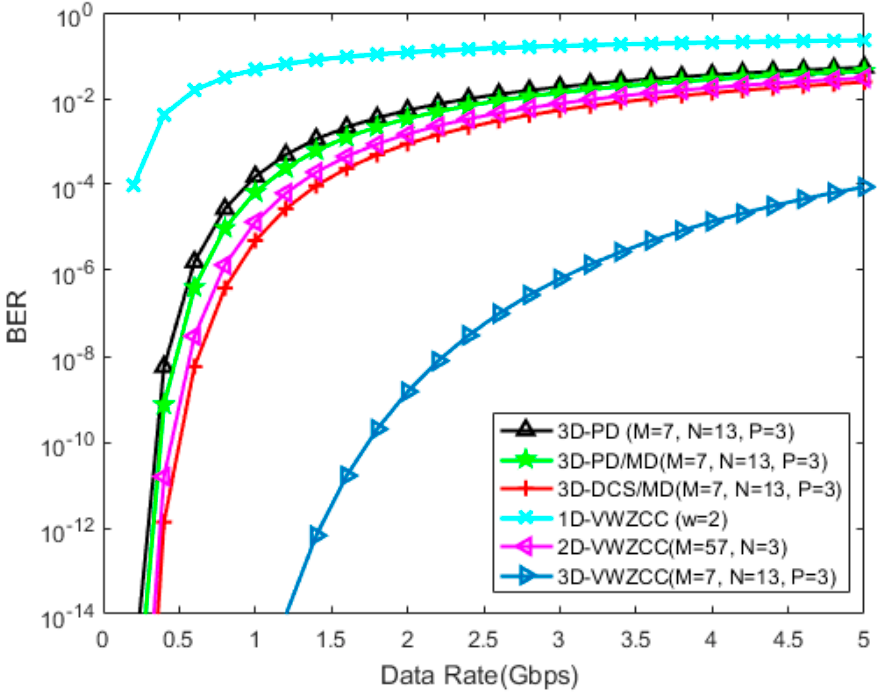
Figure 7. BER versus data rate when the number of active users K = 250 and effective source power P sr = − 10 dBm.